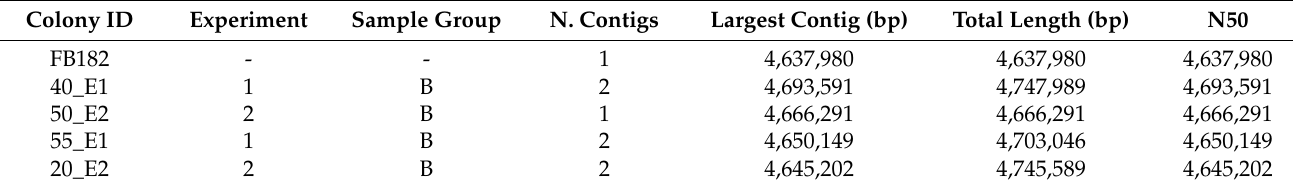
Table 3. Quality metrics of the genomic